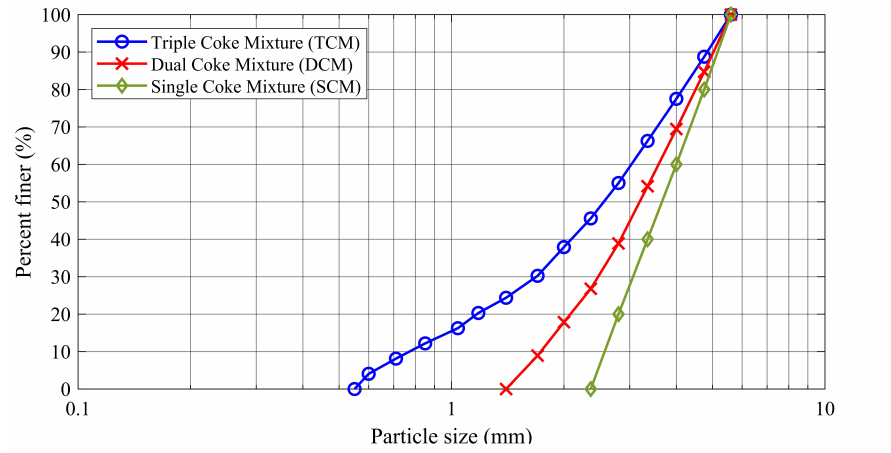
Figure 3. The particle size distributions of coke aggregates used to create specimens. Table 2. The number and distribution of particles in the